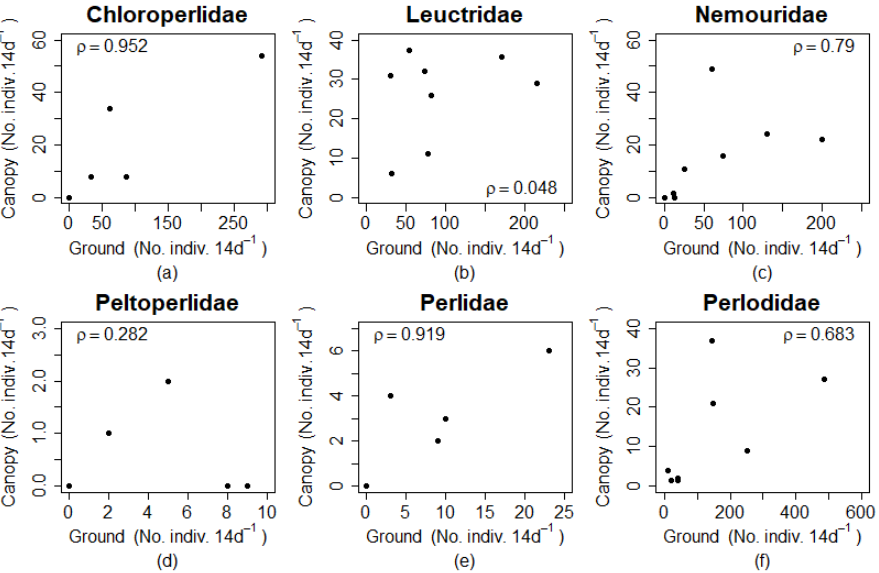
Figure 5. Scatter plot of paired ground and canopy trap abundances for each site and season individually for all ( a–f ) plecopteran families. Spearman rank-order correlation coefficients ( ρ ) indicate the strength of correlation for paired samples and are reported for each family.